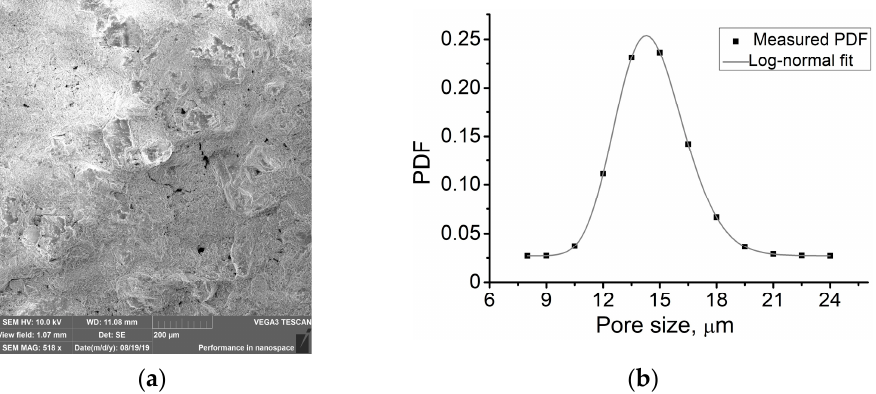
Figure A2. SEM pattern of the etched sample surface ( a ), probability density function of pore size distribution ( b ).